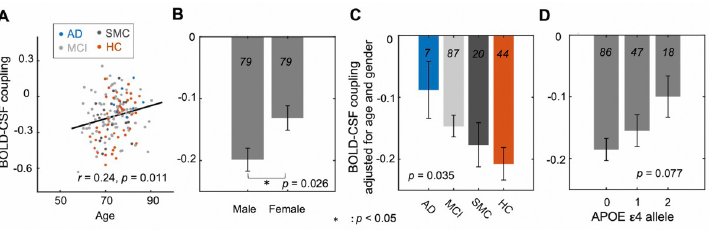
Fig 2. The dependency of the BOLD–CSF coupling on AD risk factors and disease conditions. ( A ) The strength of the BOLD–CSF coupling, quantified as the correlation between the global BOLD signal and CSF at +3-second lag, shows a significant correlation (Spearman’s r = 0.24, p = 0.011, the linear mixed model with Satterthwaite method) with age across the 158 sessions. The linear regression line was estimated based on the linear least-squares fitting [49]. ( B ) Male participants showed a larger amplitude of the BOLD–CSF coupling as compared with females ( p = 0.026). ( C ) The BOLD–CSF coupling, after adjusting for age and gender, decreases gradually ( p = 0.035) from the HCs, to SMC, to the MCI, and then to AD group. ( D ) The age- and gender-adjusted BOLD–CSF coupling is also marginally ( p = 0.077) correlated with the APOE ε 4 allele. Error bar in this figure represents the SEM. The sample sizes of each subgroups are shown by numbers on the bars of the bar plots. The data underlying this figure can be found in S1 Data. The analysis was repeated for an augmented sample with more AD patients and HCs; see S1 Fig for the results. AD, Alzheimer disease; APOE, apolipoprotein E; BOLD, blood oxygen level–dependent; CSF, cerebrospinal fluid; HC, healthy control; MCI, mild cognitive impairment; SEM, standard error of the mean; SMC, significant memory concern.